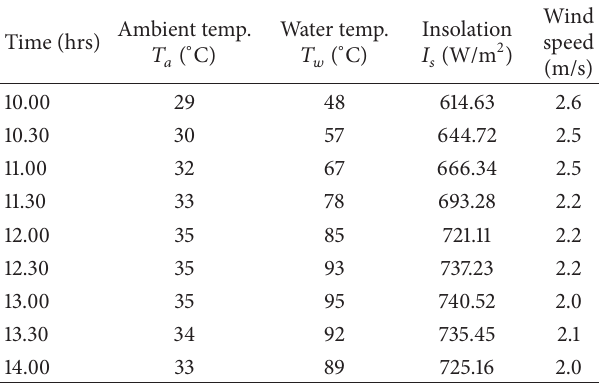
Table3:Thermalloadtest,heatupconditiontest( 𝐹 2 ) (07/03/2013)